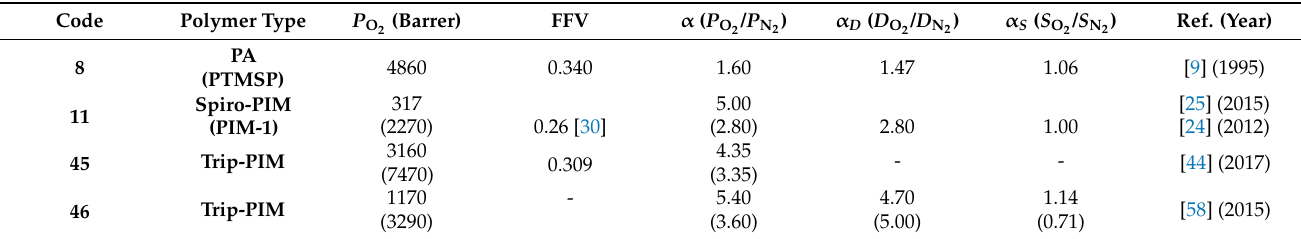
Table 6. Fractional free volume (FFV) and diffusion and dissolution selectivities for selected polymers. Code Polymer